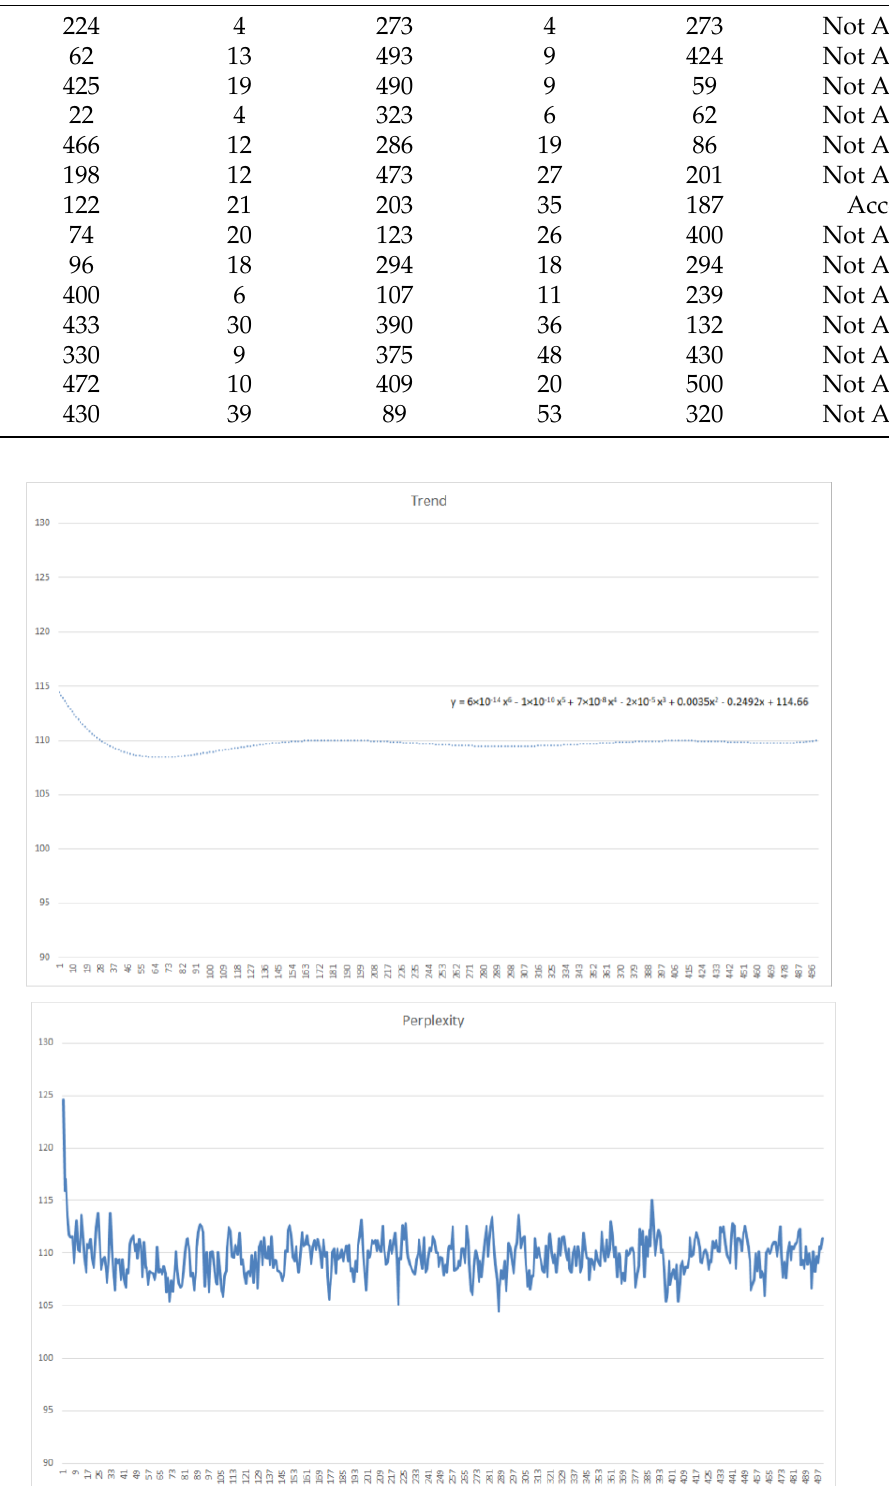
Figure 7. Accepted perplexity value and trend